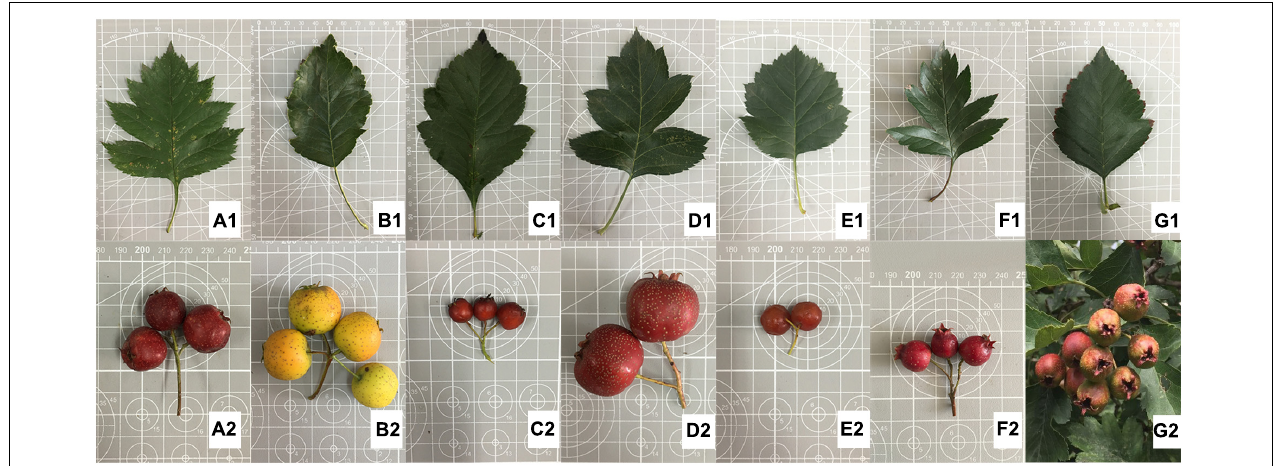
FIGURE 1 | Morphological illustration of the seven Crataegus species investigated. (A) C. bretschneideri – 82015, (B) C. hupehensis – HB1H, (C) C. maximowiczii – NASZ, (D) C. pinnatifida var. major – JD1H, (E) C. sanguineae – LN1H, (F) C. pinnatifida – HGSLH, (G) C. scabrifolia –